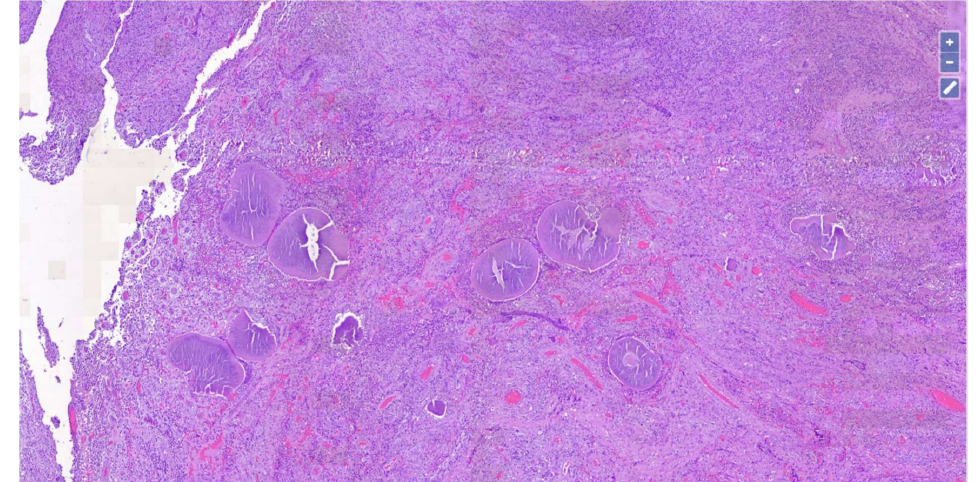
Figure 2. Chronic inflammatory infiltration of giant cell epithelioid-granulomatous around haema- toxylinophilic material consisting of grains and host organic substances (Hematoxylin-Eosin, Original Magnification: 4 ×